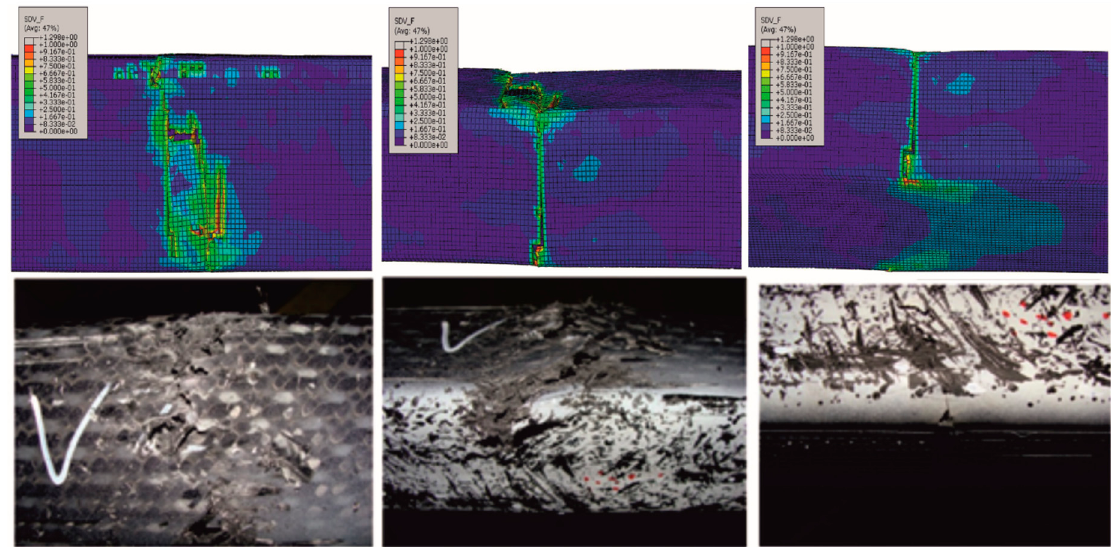
Figure 10. Comparison of the fracture phenomena between simulation and drop tower test (bumper bracket configuration (a), layup: 4 layers ±45° with 0° filler yarn (2D triaxial braid), m imp = 435 kg, v imp = 1 6 km/h): front-side ( left ), lateral surface ( middle ) and backside ( right ).